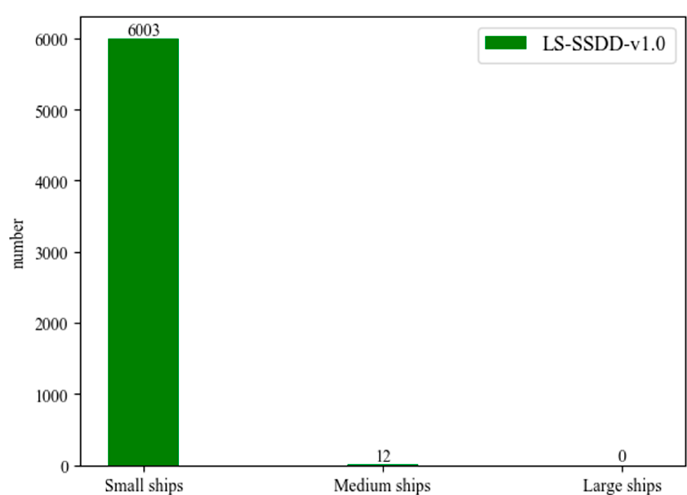
Figure 8. The distribution of the ship’s shape.